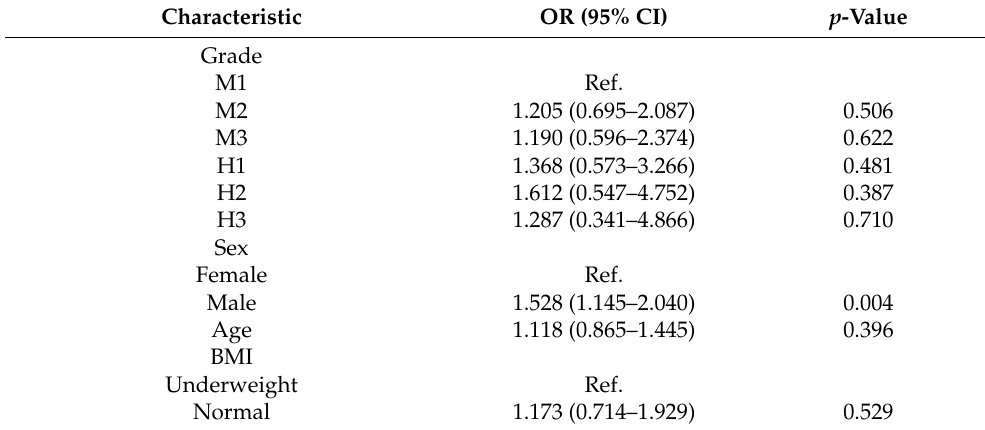
Table 3. Odds ratios for the presence of self-perceived PLMS in participants with restless legs